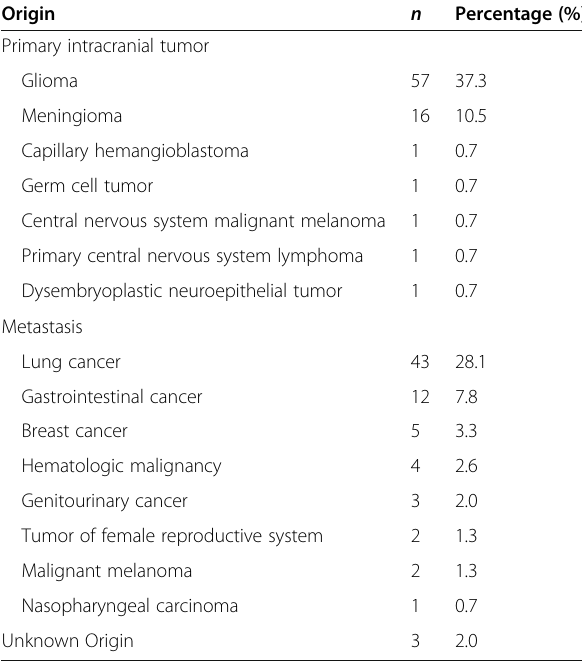
Table 1 Types of tumor origin in 153 cases of brain tumor- related epilepsy